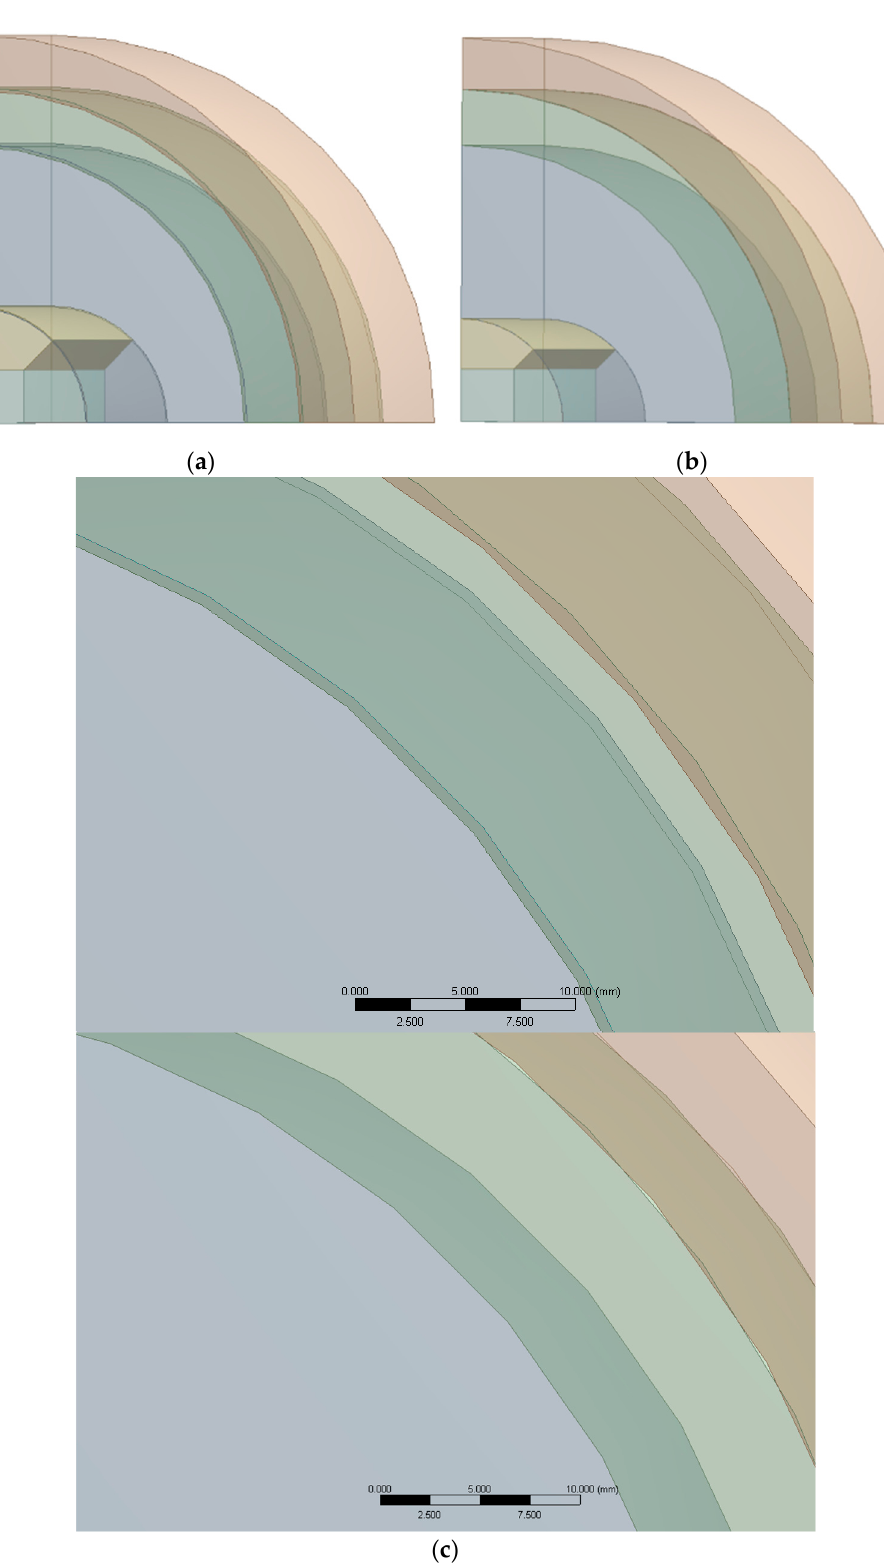
Figure 7. ( a ) Geometric interference modeling diagram. ( b ) Contact interference modeling diagram. ( c ) Comparison of modeling between the two methods.